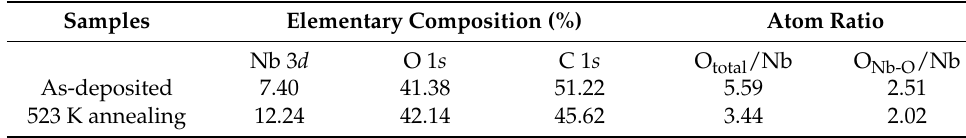
Figure 5. XPS results of ( a ) Nb 3 d and ( b ) O 1 s on the films. Table 1. XPS results of the element content on the Table 1. XPS results of the element content on the films.